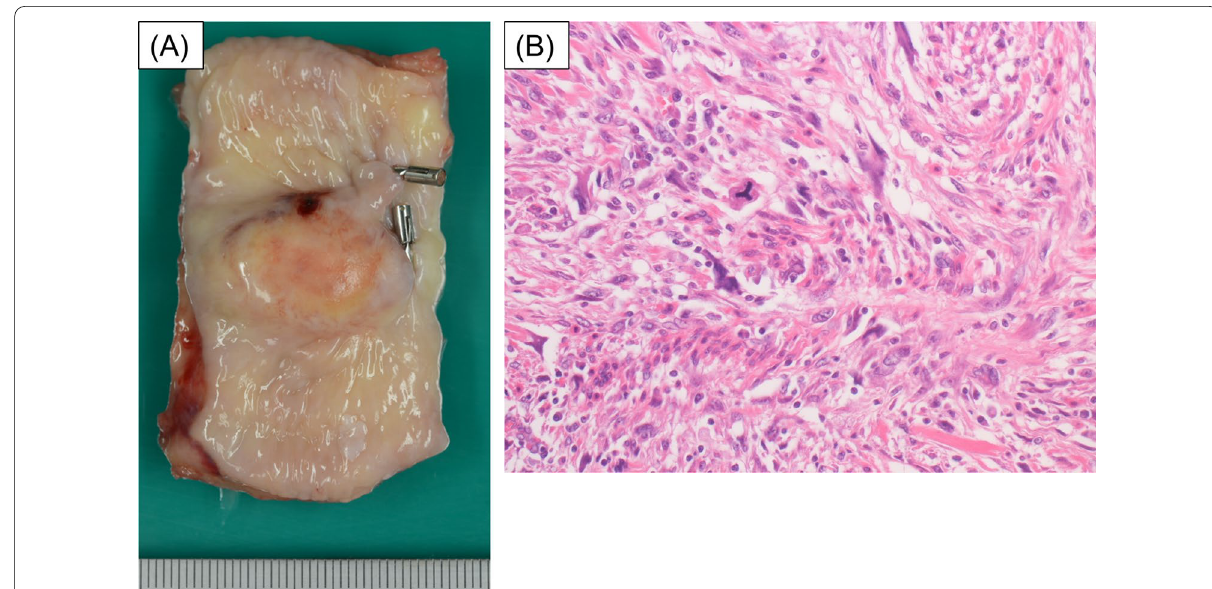
Fig. 5 Macroscopic finding of the esophageal tumor, 3.0 proliferation with storiform pattern in the submucosal layer ( B ). (Hemotoxylin and eosin stain, 200